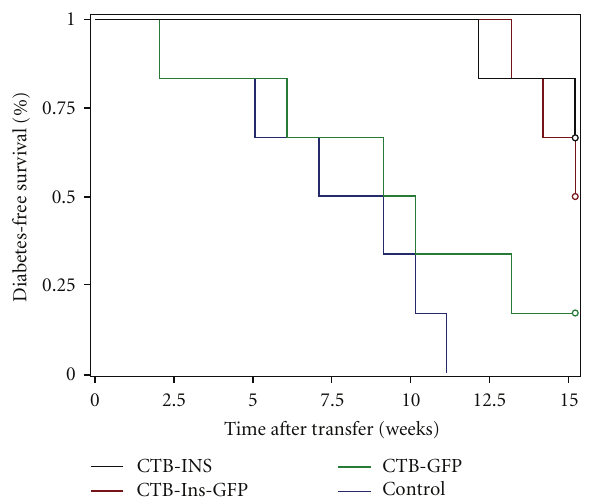
Figure 9: Splenocytes from insulin-fed NOD mice prevented diabetes after adoptive transfer. Splenocytes (1 × 10 7 cells) isolated from CTB-INS- (group 1, black), CTB-Ins-GFP- (group 2, red), and CTB-GFP- (group 3, green) fed mice at 10 weeks of age were mixed with diabetogenic splenocytes (1 × 10 7 cells) from diabetic NOD mice, and then cotransferred to 8-week-old NOD/SCID mice ( n = 6 for all four groups) with a diabetogenic splenocyte-only injection (group 4, blue) as a control. The development of diabetes in the recipients was monitored for 15 weeks. The ANOVA test revealed a significant reduction in T1D onset in groups 1 and 2 compared with groups 3 and 4 ( P = . 0001). No significant di ff erence was found between groups 3 and 4 ( P = .